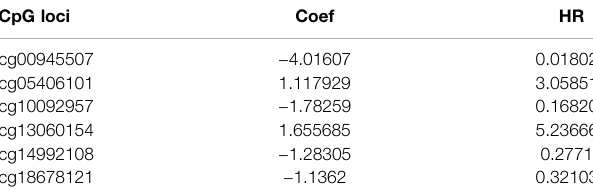
TABLE 3 | Formula of Methylation prognostic model. CpG loci Coef